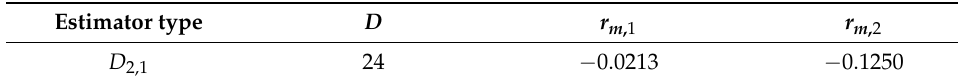
Table 2. Coefficients for Considered Values of D for K = 2.